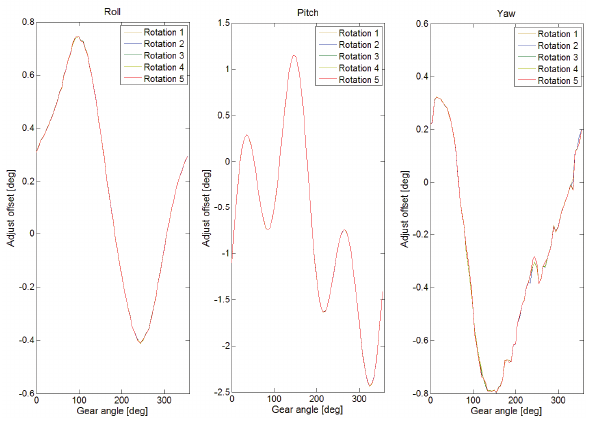
Figure 12. Angular correction boresights, repeated for 5 full circles